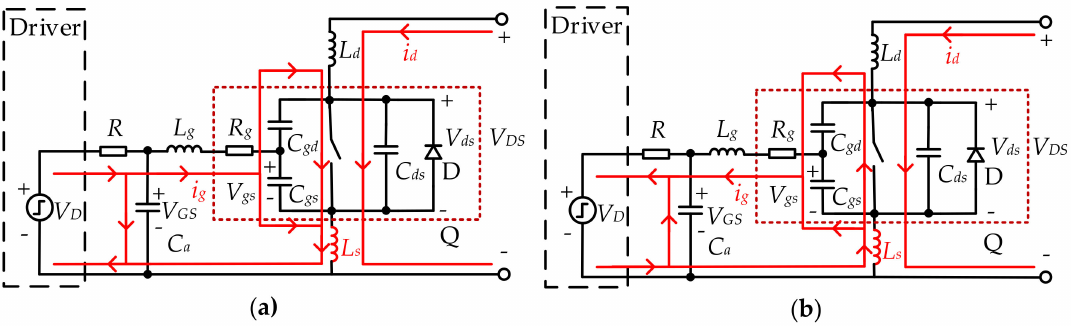
Figure 4. The current flow of general 3-pin SiC MOSFET during switching: ( a ) Turn-on process, ( b ) Turn-o ff